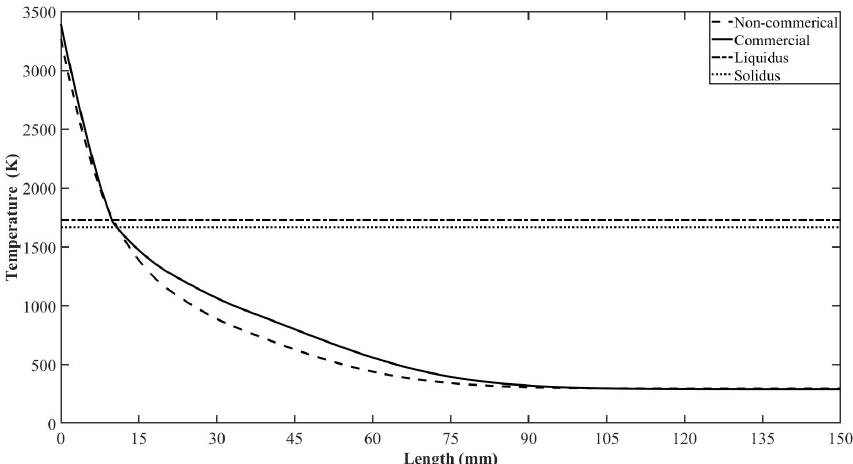
Figure 9. Comparison of maximum value of temperature obtained by the non-commercial model and commercial model along the length of the cylindrical rod.